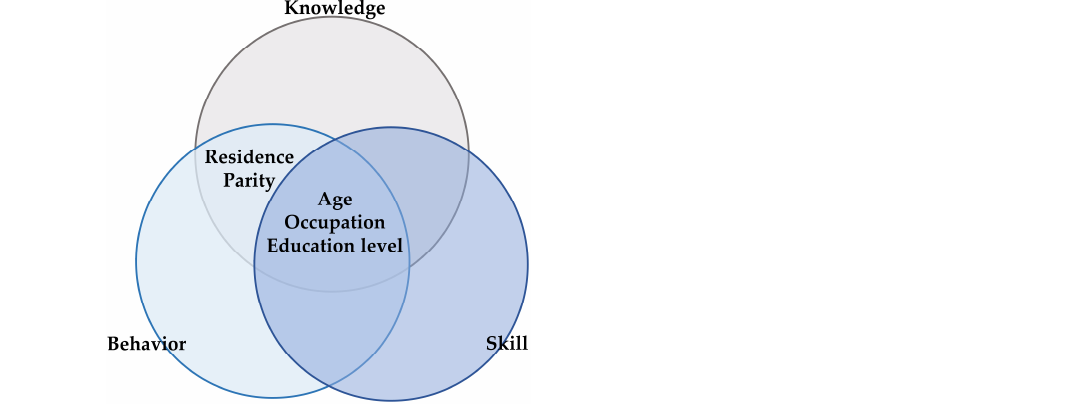
Figure 2. Venn diagram of influencing factors of nutritional literacy scores in Chinese pregnant women.